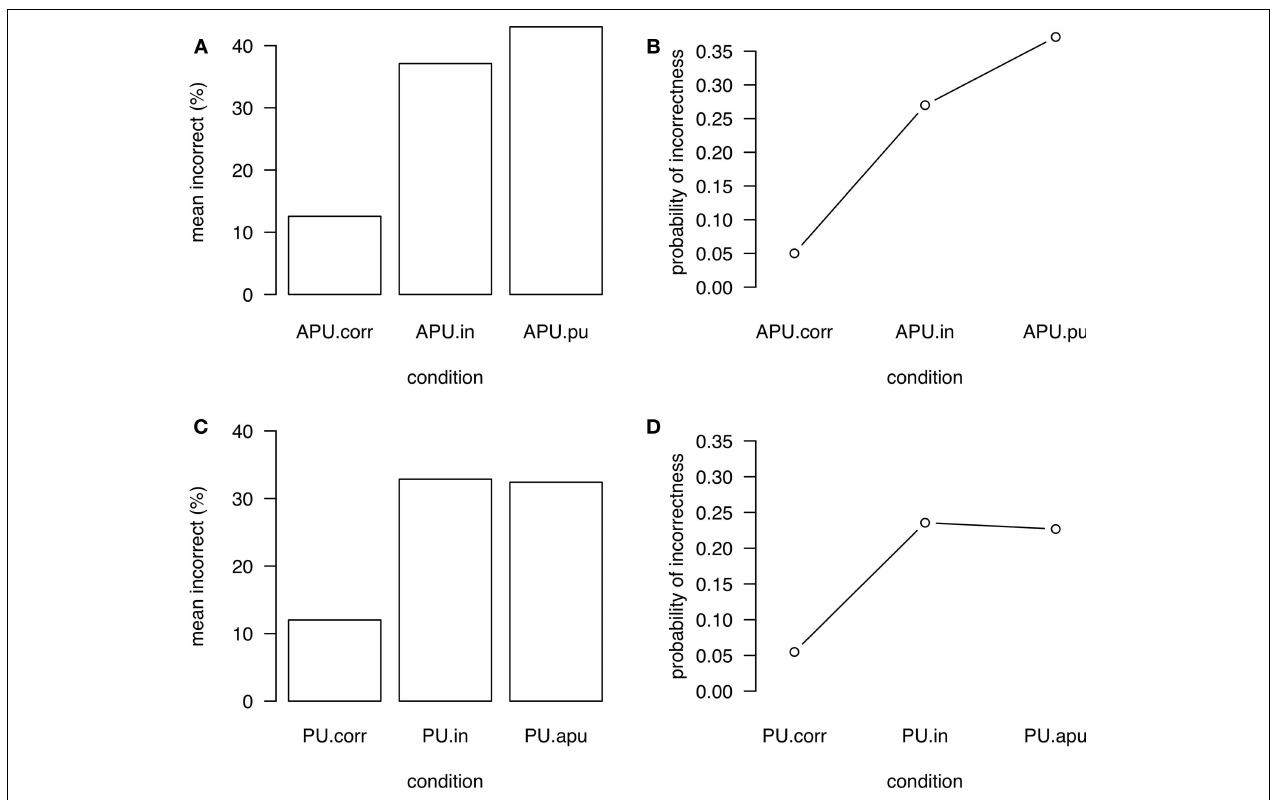
FIGURE 2 | Descriptive means of incorrect responses (A) for words with canonical antepenultimate stress and (C) for words with canonical penultimate stress and probability of incorrect